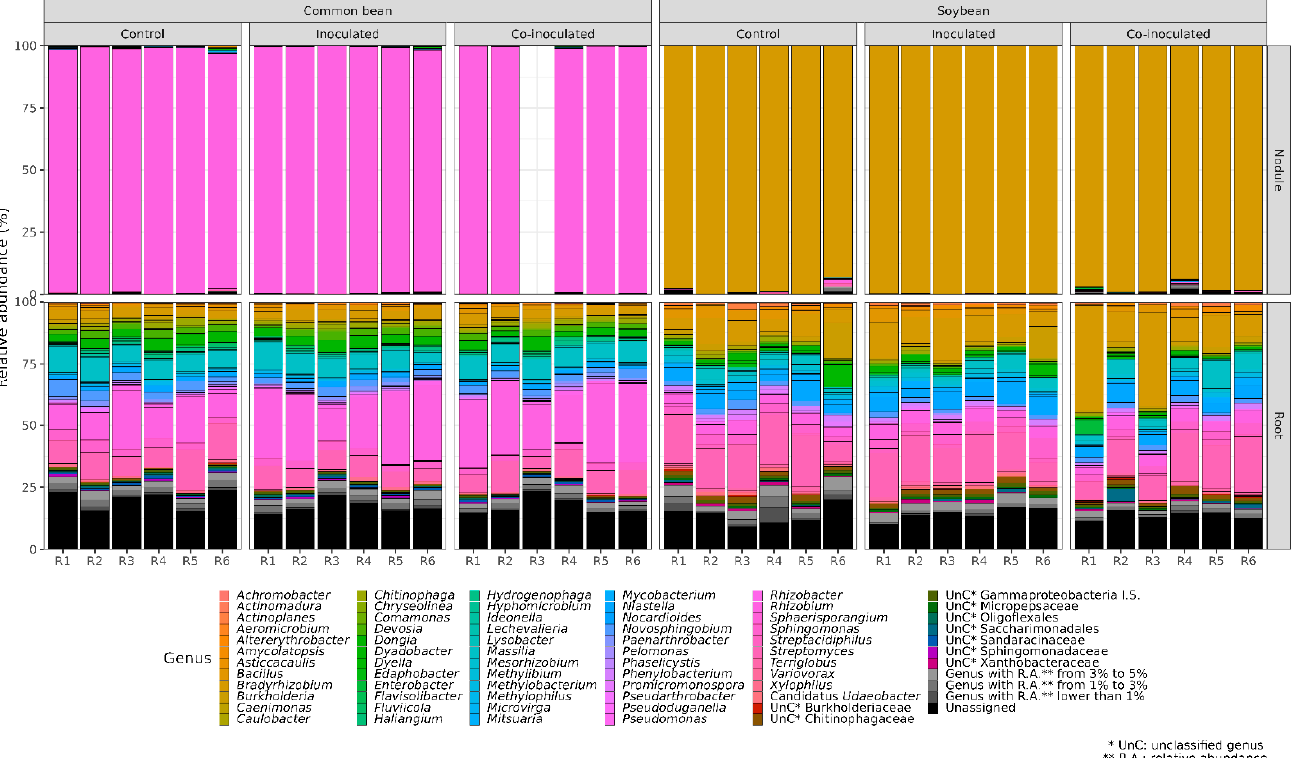
Figure 1. Relative abundance (%) of the genera detected in the microbiomes of soybean and common bean nodules and roots. Treatments included (i) non-inoculated controls; (ii) soybeans inoculated with Bradyrhizobium japonicum strain SEMIA 5079 + Bradyrhizobium diazoefficiens SEMIA 5080, and common beans inoculated with Rhizobium tropici CIAT 899; and (iii) both legumes co-inoculated with the specific rhizobia and Azospirillum brasilense strains Ab-V5 and Ab-V6. R1 to R6 refer to six biological replicates of each treatment, and the white column in one nodule of common bean was due to a sample loss.